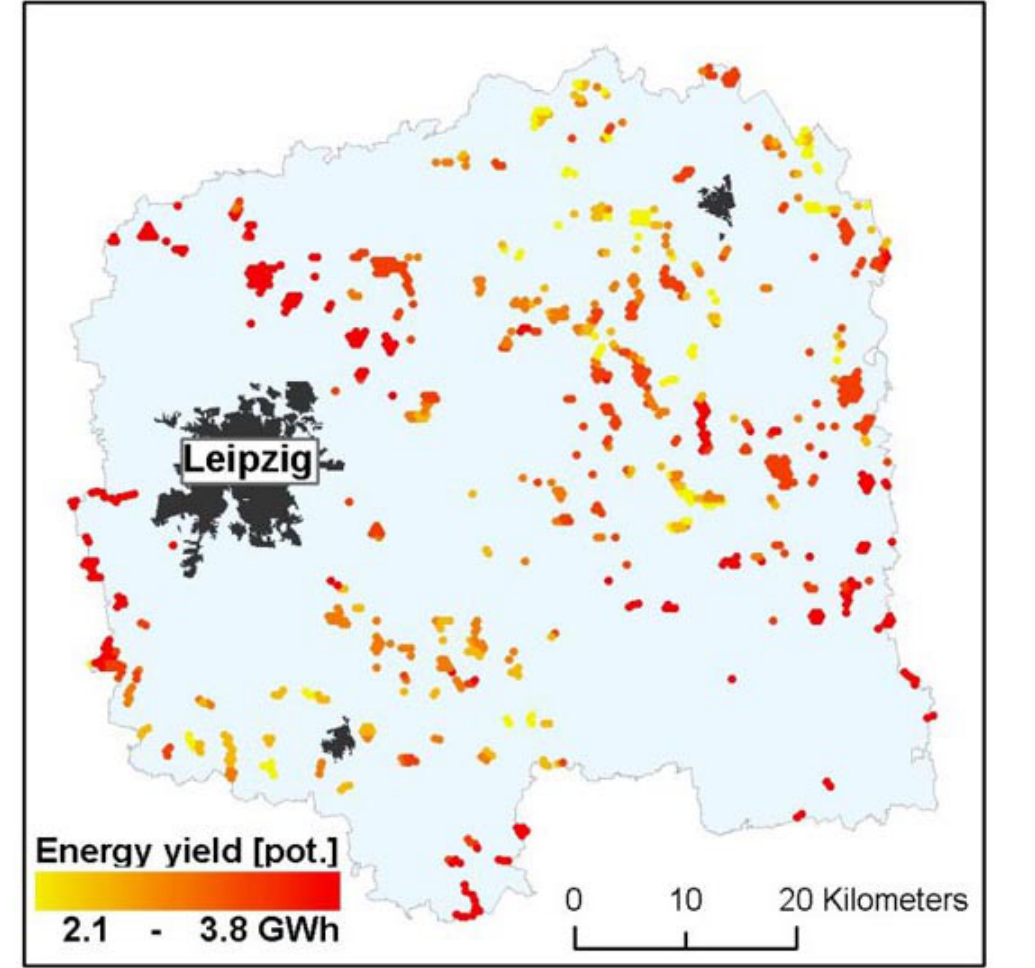
Fig. 3 . Energy production map. Each dot represents a potential wind turbine site. Color represents the amount of energy that can be produced per year at the site. Black represents